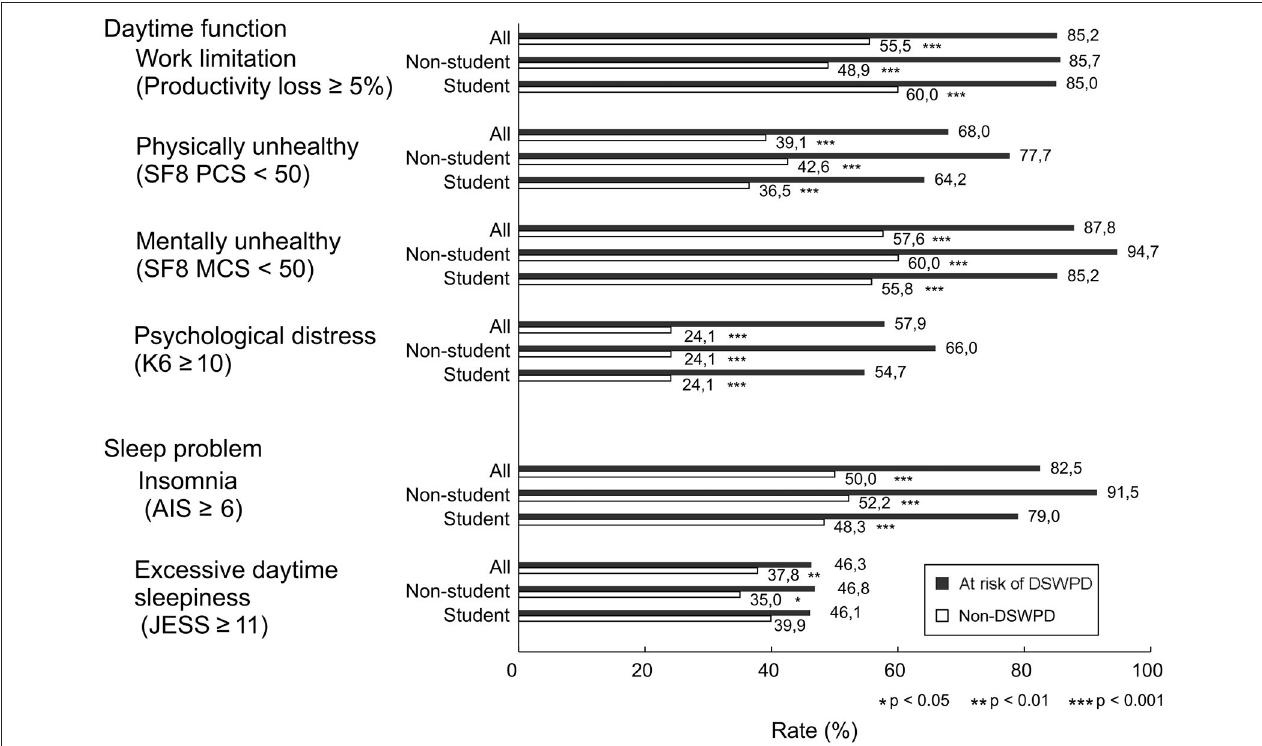
FIGURE 1 | Differences in daytime dysfunction and sleep problem variables of participants at risk of DSWPD and those without DSWPD. Bars represent percentage of people with Productivity loss ≥ 5%, SF8 PCS < 50, SF-8 MCS < 50, K6 ≥ 10, AIS ≥ 6 and JESS ≥ 11. Black and white bars indicate the group at risk of DSWPD and the non-DSWPD group, respectively. Significant differences were noted as * P < 0.05, ** P < 0.01 and *** P <